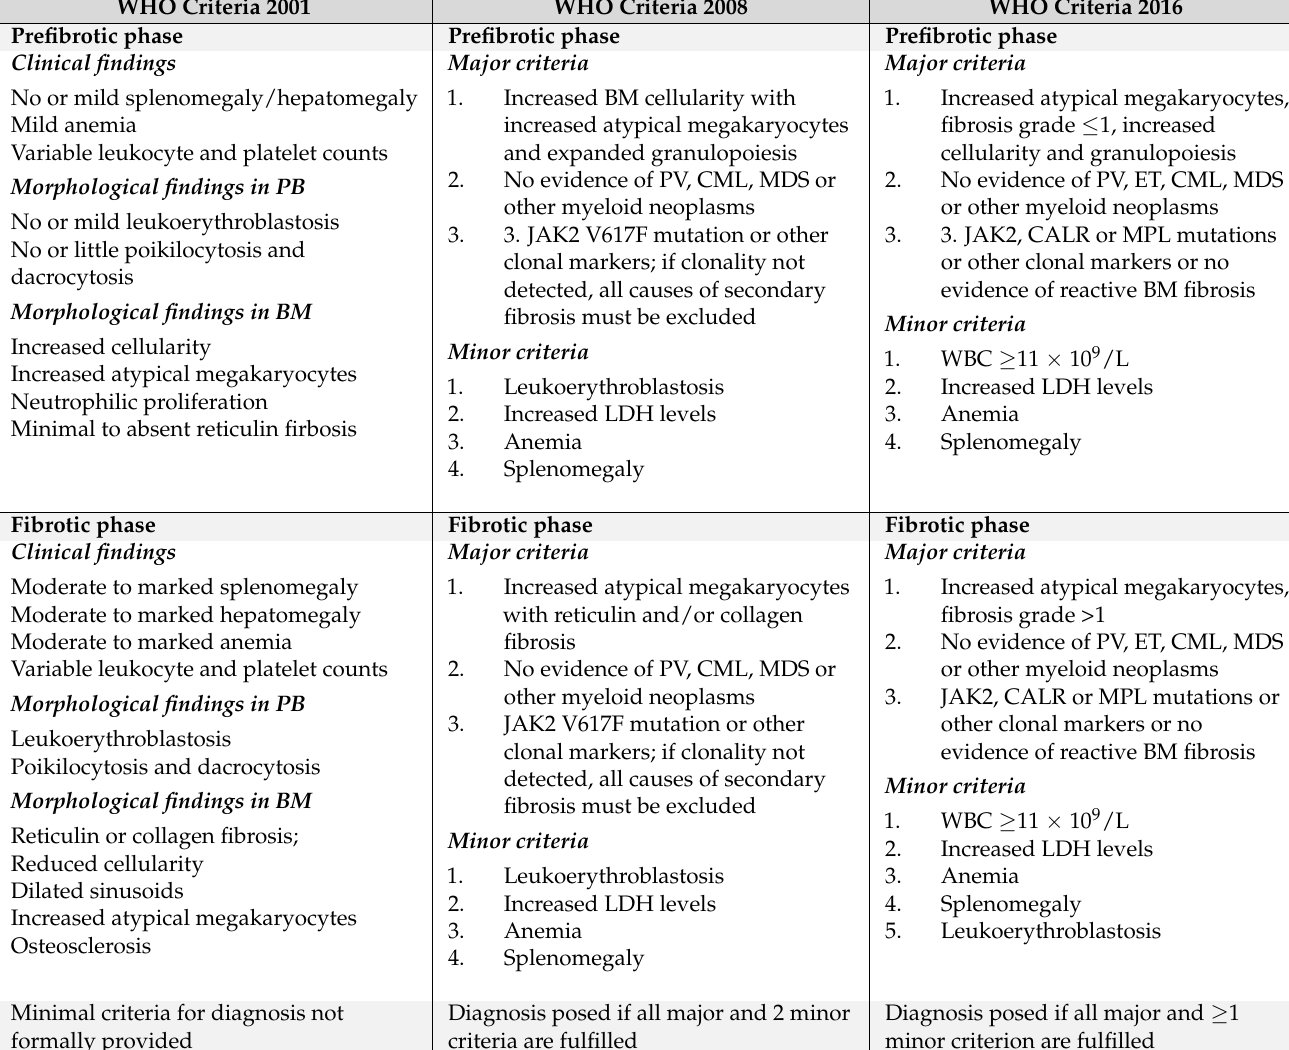
Table 4. Evolution of diagnostic criteria for Primary